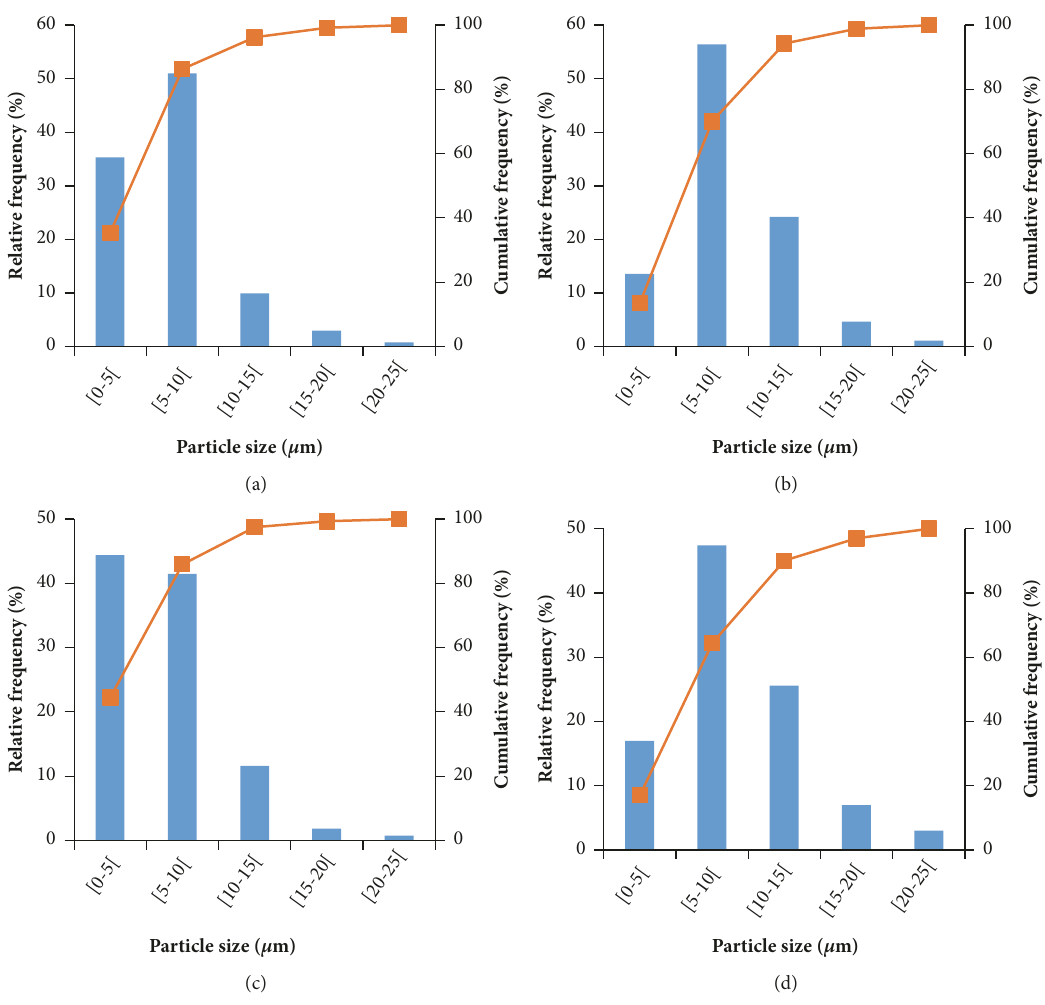
Figure 3: Relative frequency (bars) and cumulative frequency (line) equivalent to the diameter of microparticles. (a) 9.4 %AG, 123.2 ∘ C; (b) 9.4 %AG, 186.8 ∘ C; (c) 5 %AG, 155 ∘ C; (d) 35 %AG, 155 ∘ C. Table 2: Second-order polynomial equations for each response